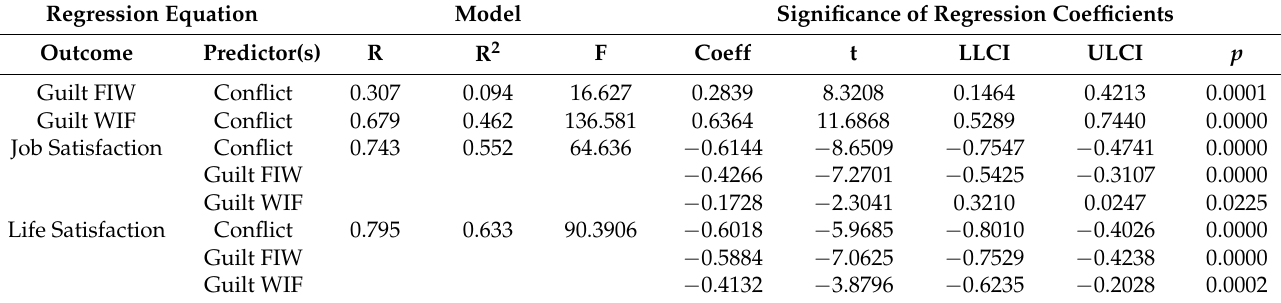
Table 3. Mediation